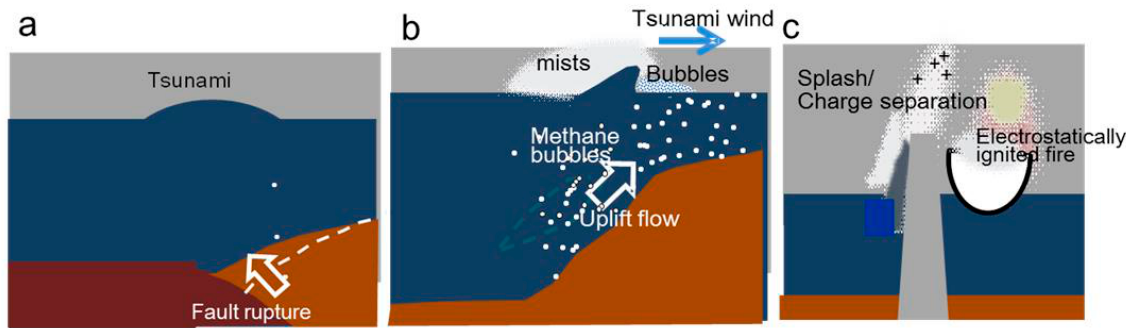
Figure 6. ( a – c ) Model showing how the boat fires could have started due to electrostatic ignition of methane-bearing bubbles (generated from the seabed due to the earthquake) striking the seawall.